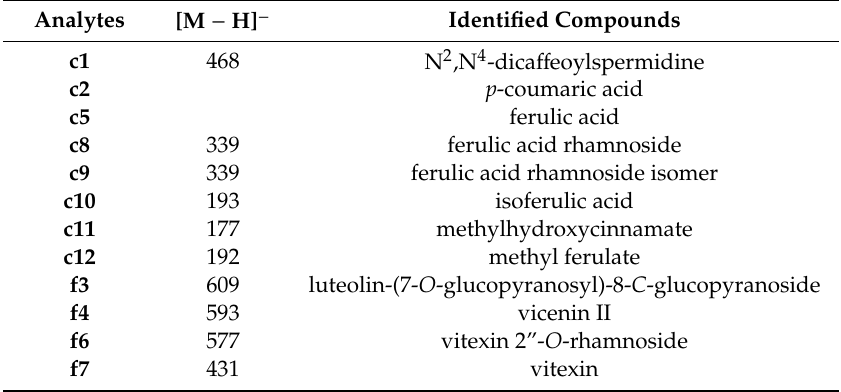
Table 1. List of the identified compounds in millet samples .